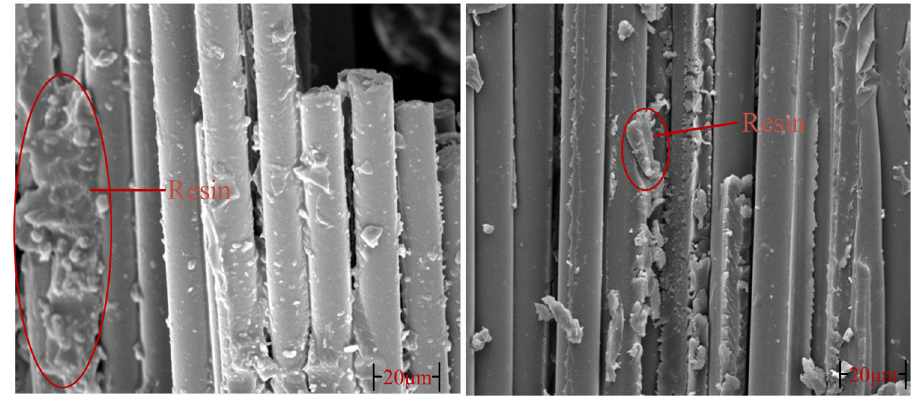
Figure 8: Fiber/matrix interfacial micromorphology of sandwich panels with and without hydrothermal